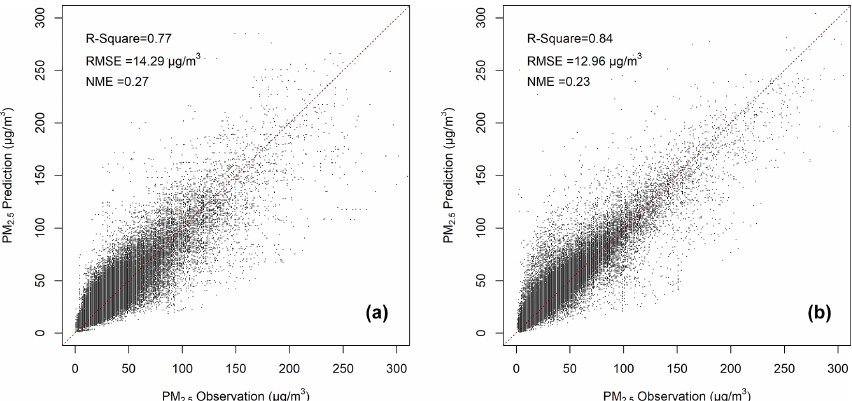
Figure 6. Scatter plots of predictions versus observations respectively evaluated using the (a) LCCV and (b) LSCV methods.